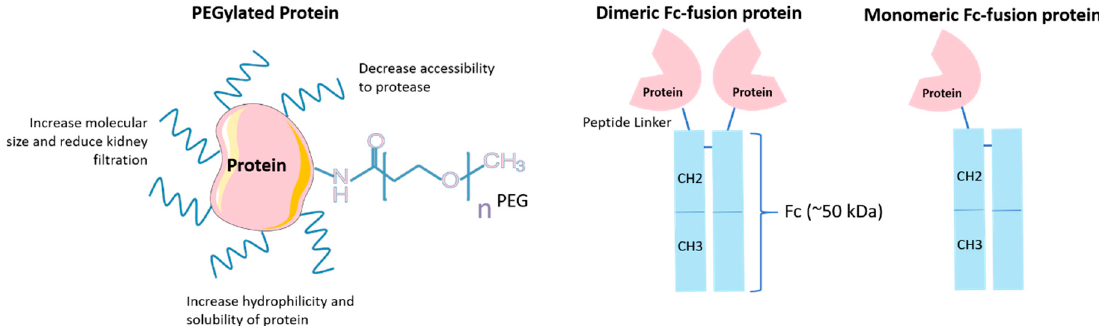
Figure 4. Structure of PEGylated protein and Fc-fusion protein. PEGylation is a chemical process involving the attachment of polyethylene glycol (PEG) chains to a molecule of interest through covalent binding or non-covalent complexation; Fc-fusion proteins are composed of the Fc domain of IgG genetically linked to a peptide or protein of interest. The first-generation Fc-fusion proteins are dimeric wherein an effector molecule is fused with each arm of the Fc fragment. The second-generation Fc-fusion proteins are monomeric wherein a single effector molecule is conjugated to one arm of the Fc fragment.